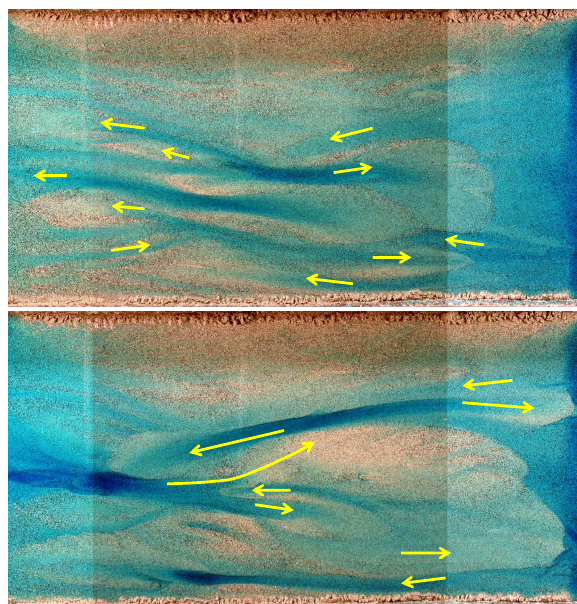
Fig. 3. Top view on transitional V-shaped to diamond-shaped tidal bars in moderate-energy experiment 2 after about 300 and 3000 tidal cycles. Arrows indicate dominant tidal flow direction.